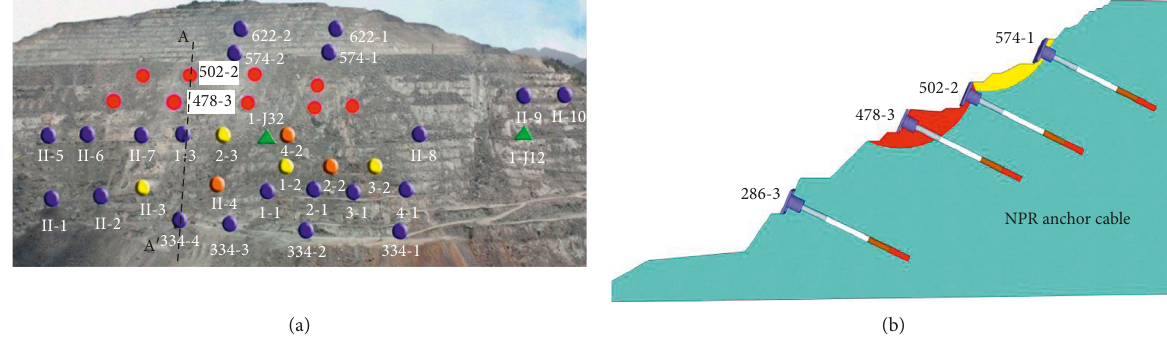
Figure 13: Monitoring point distribution: (a) added monitoring point distribution characteristics; (b) section A-A